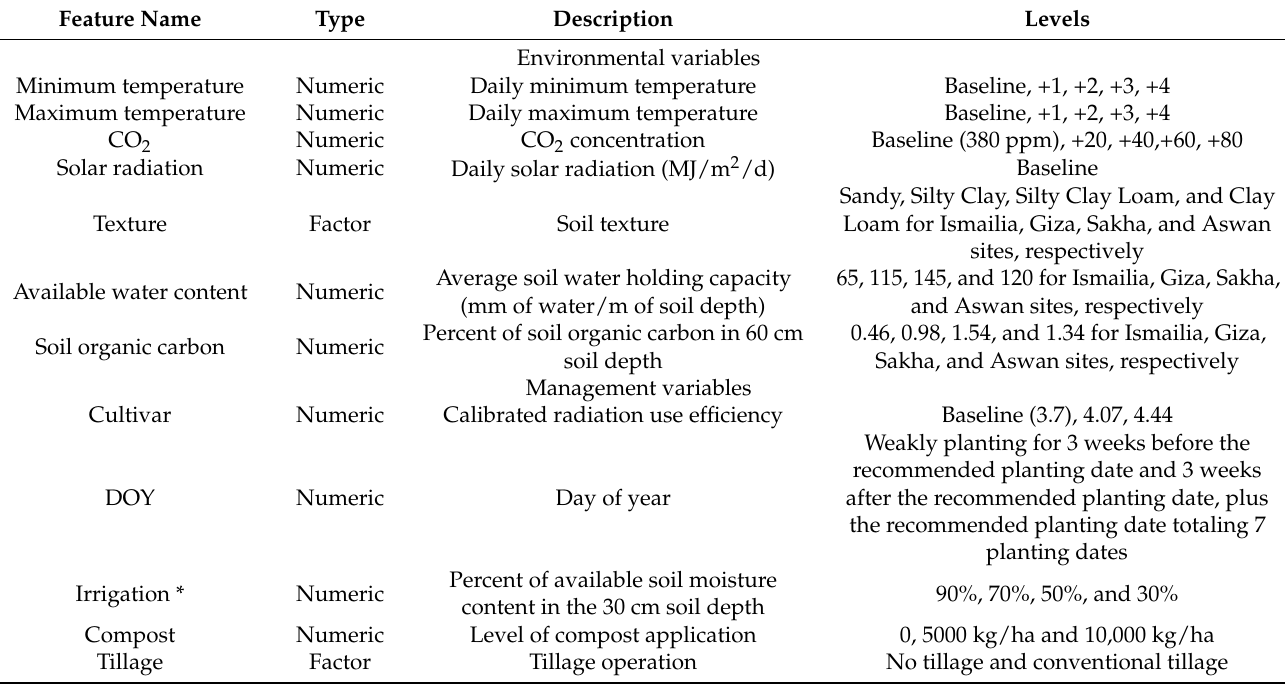
Table 2. Environmental variables and management variables used as input features for model